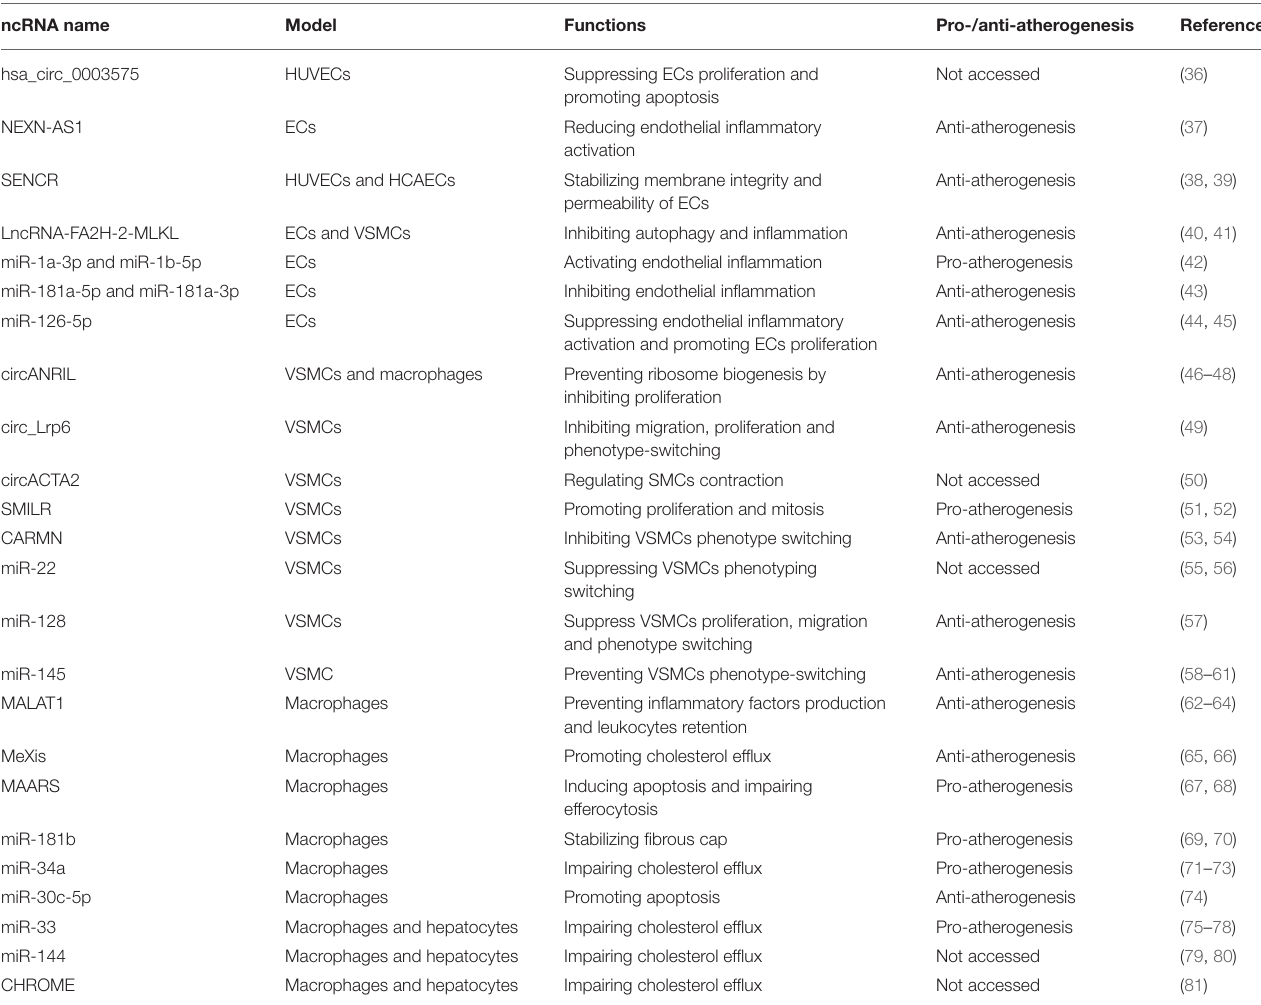
TABLE 1 | Non-coding RNAs in